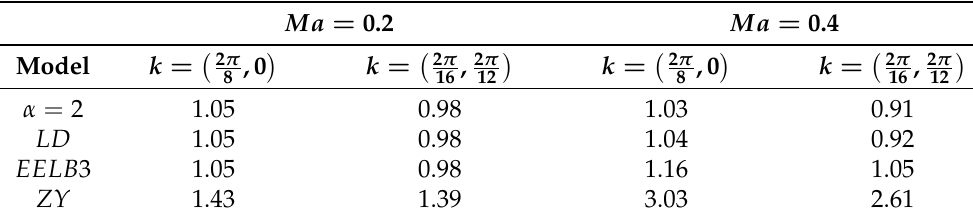
Figure 4. Shear waves, upper slides: Ma = 0.2, lower slides: Ma = 0.4; left slides: k x = 2 π /8, k y = 0; and the right slides: k x = 2 π /16, k y = 2 π /12. LD is the low-dissipative entropic method described in Proposition 1; EELB 3 is the third-order EELB method; ZY is the method of Zhao and Yong. The Navier–Stokes solutions are denoted as: ( − ) . Table 2. Shear waves, the ratios ν e / ν ( ν e is the viscosity measured during the numerical simulations, ν is the theoretical viscosity) are presented. α = 2 is the standard LB method; LD is the low-dissipative entropic method described in Proposition 1; EELB 3 is the third-order EELB method; ZY is the method of Zhao and Yong.